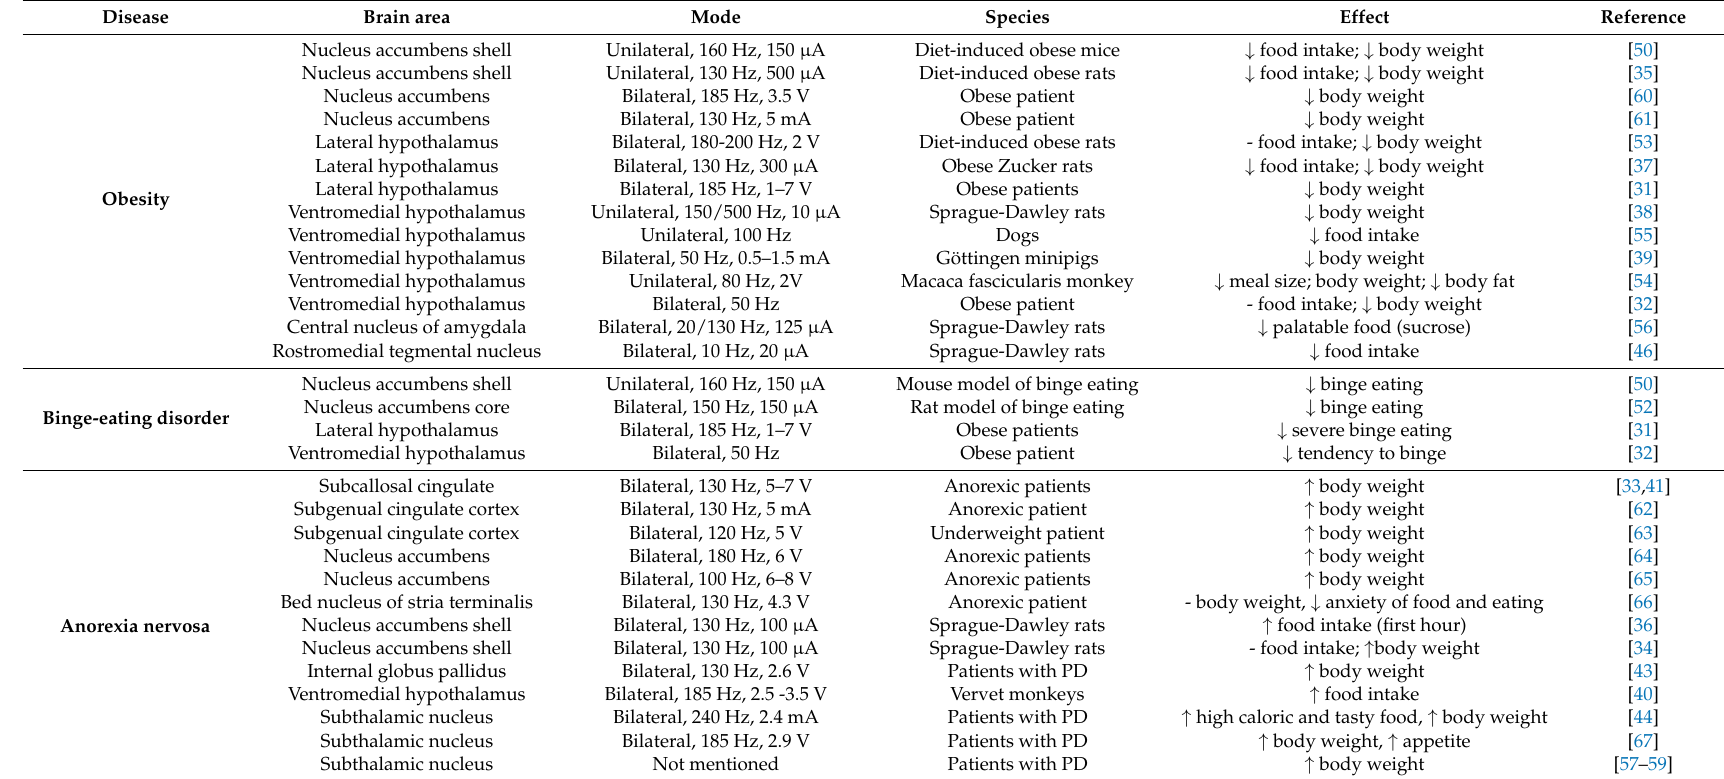
Table 1. Overview of current studies focusing on the effects of DBS on eating behavior and body